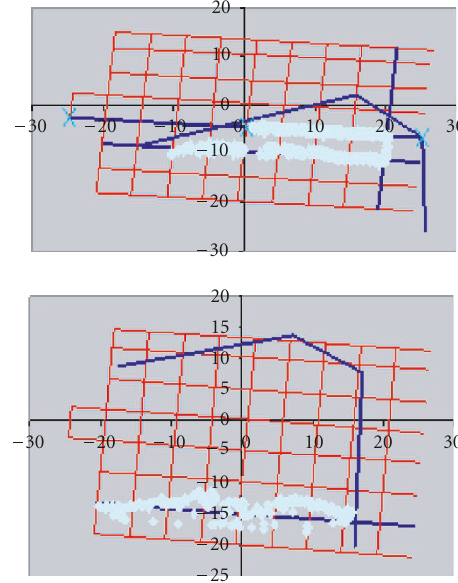
Figure 16: 2D trajectory graph for the person object (S27-Camera 2, person 8 (left) and Camera 4, person 13 (right)). The light (red) lines represent the patching lines and the light (blue) lines represent the camera field of